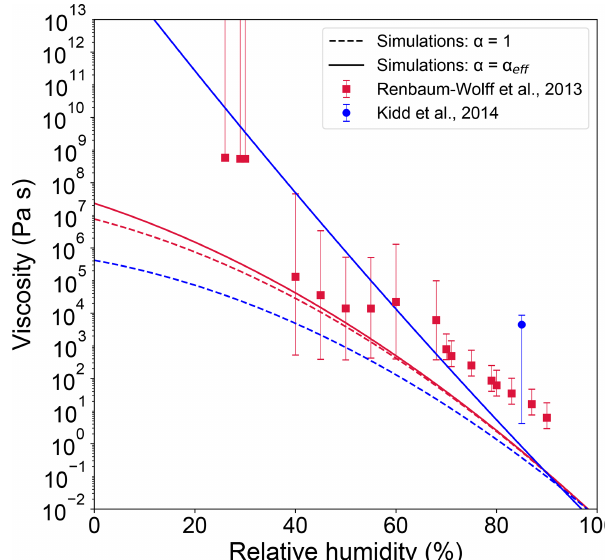
Figure 6. Simulated viscosities of α -pinene SOA with experimen- tal conditions of Kidd et al. (2014) (blue) and Renbaum-Wolff et al. (2013) (red). The simulations were conducted in two different scenarios: α = 1 (dashed lines) and α = α eff (solid